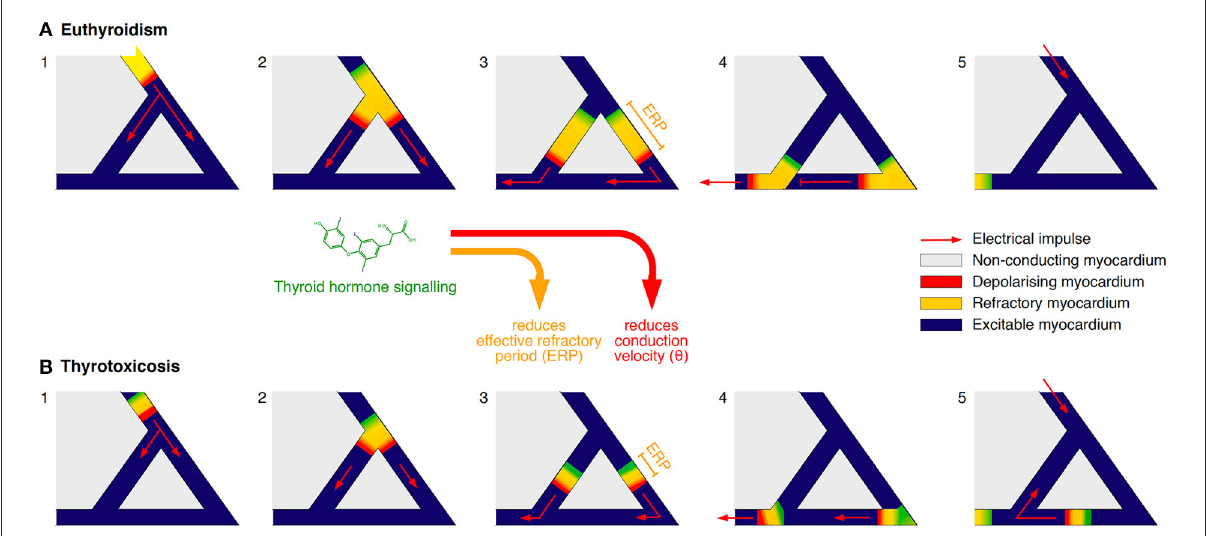
FIGURE4 (A,B) Simplified model of the effects of thyroid hormone signaling facilitating disorders of impulse conduction. Iodothyronine action reduces both the effective refractory period ( ERP ) and the conduction velocity ( θ ). As a consequence, the wavelength of excitation λ = ERP x θ may get shorter than the dimensions of a potential re-entry circuit, thus giving rise to re-entrant tachycardia